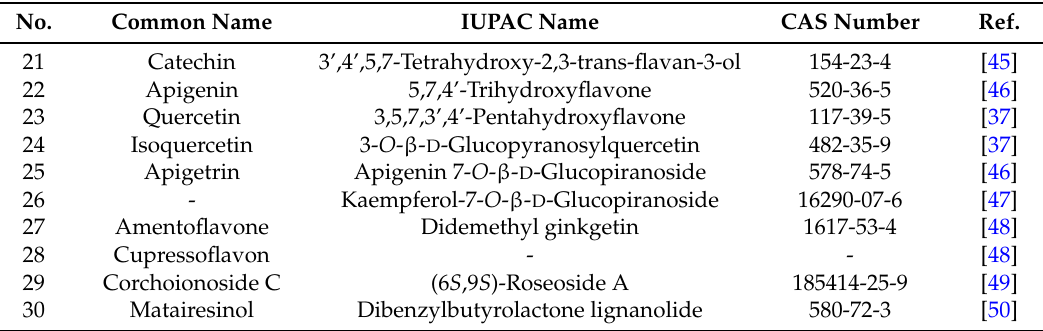
Table A2. Compounds 21 – 30 identified by methanol extract of J. communis .